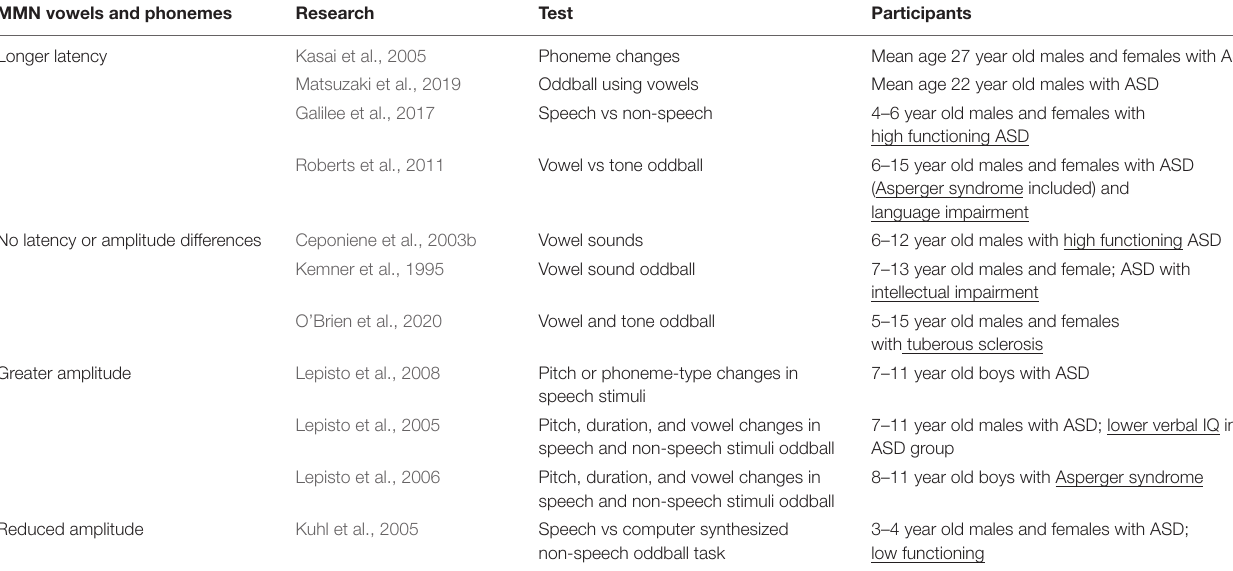
TABLE 4 | MMN in response to vowel and phoneme